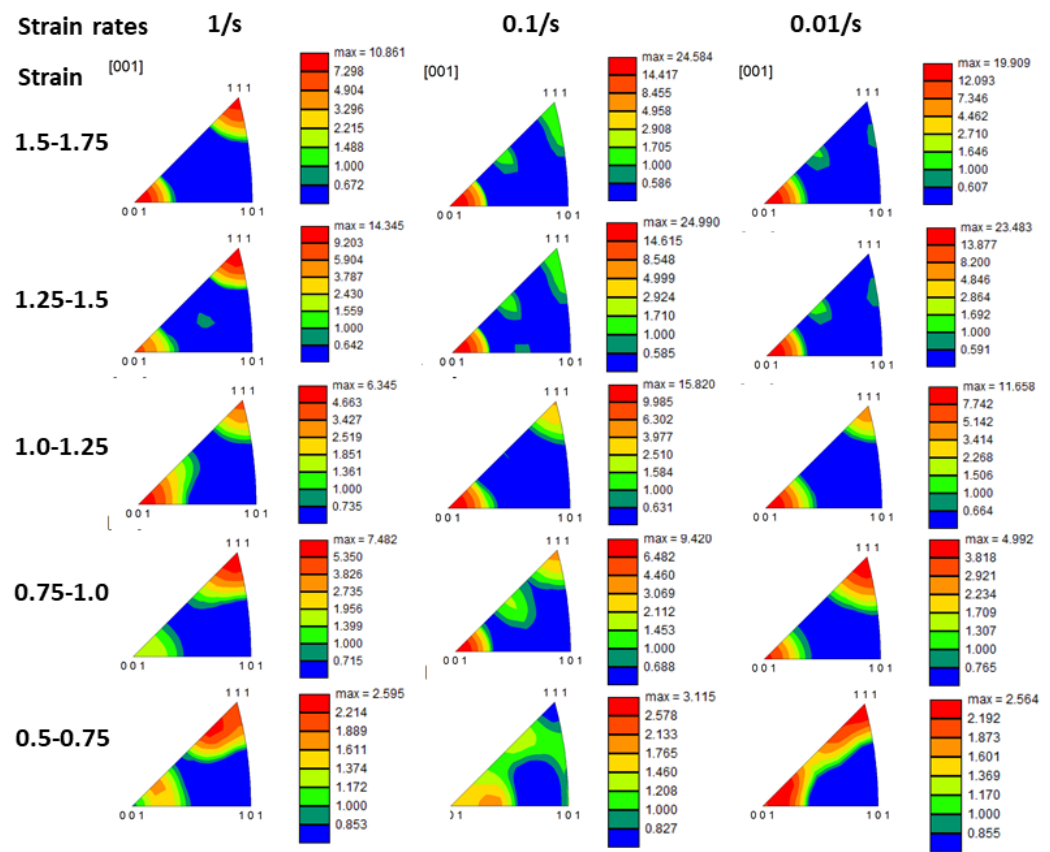
Figure 4. Inverse pole figures evolution with respect to the different strain regions and strain rate of the deformed Ti55511 at 950 °C.